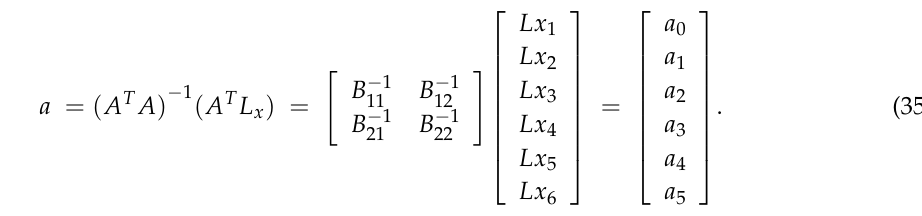
in the circle represents the left shift operation.